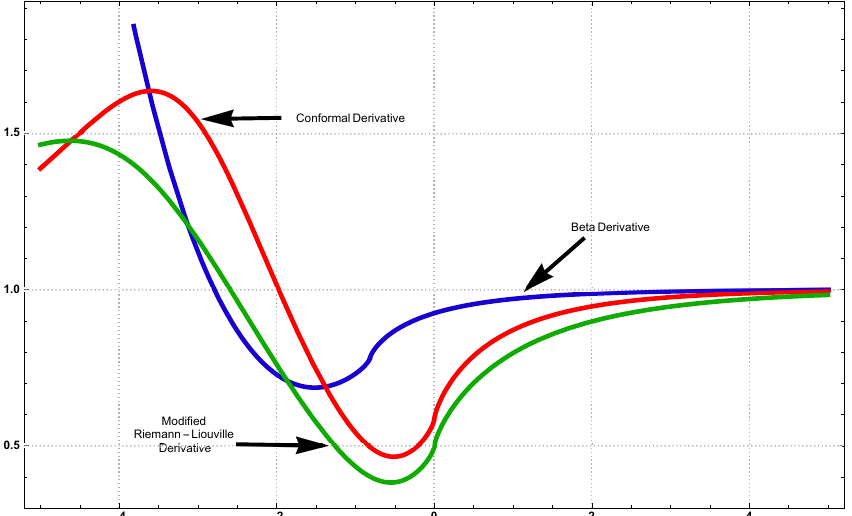
Figure 15. Comparative investigation of the dark soliton solution | L 6 ( t , x ) | via the modified Riemann–Liouville, conformable and beta derivatives for the fix value of fractional order β = 0.75 defined by these fractional